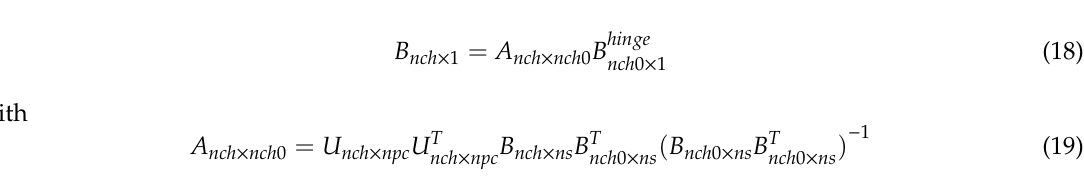
( b ) Figure 5. ( a ) The RMS errors of the simulated BRDFs using method described in [43,45]; ( b ) The RMS errors of the simulated BRDFs using HSBR model reported in this paper.